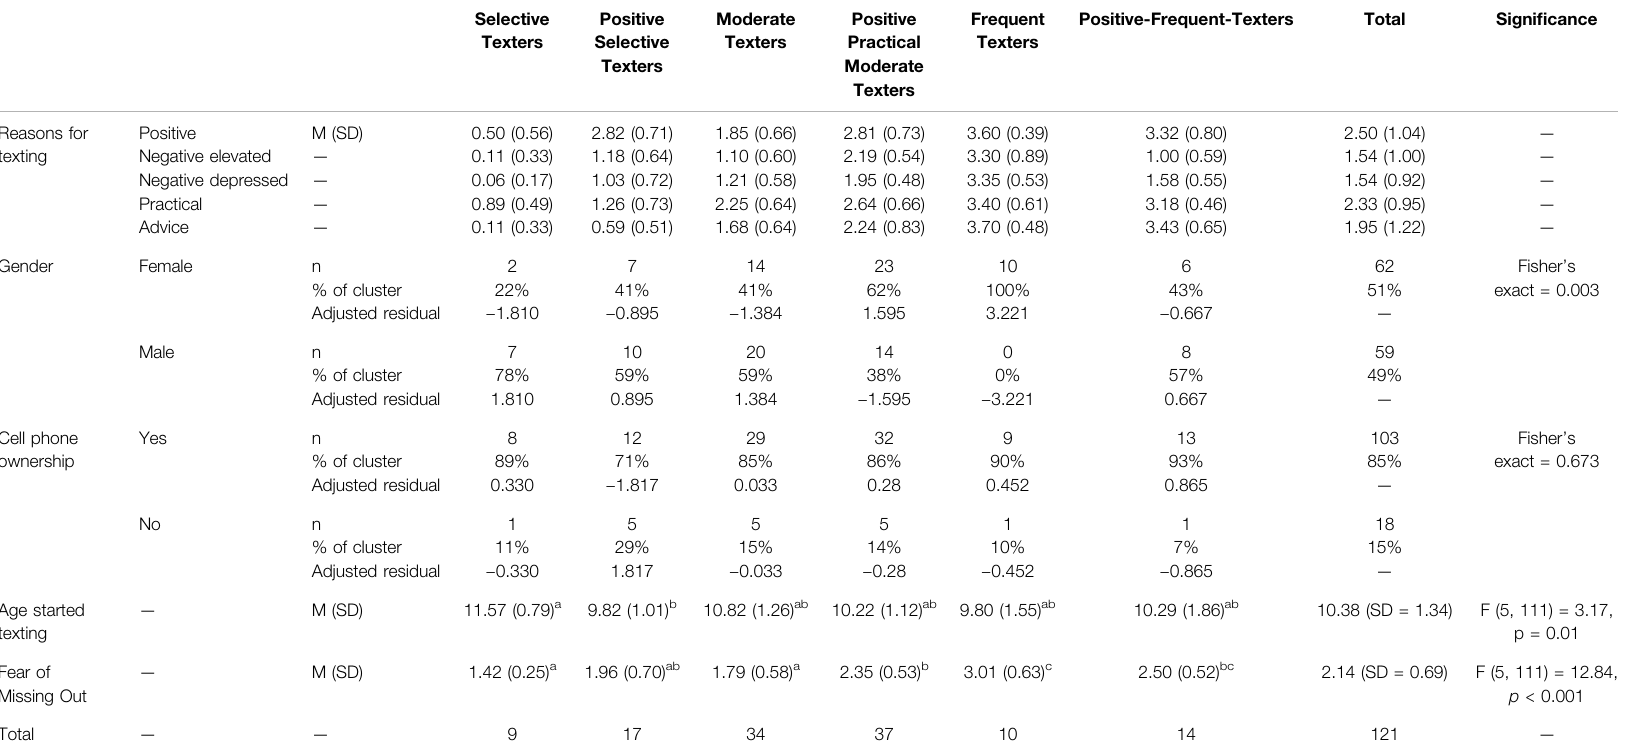
TABLE 1 | Cluster